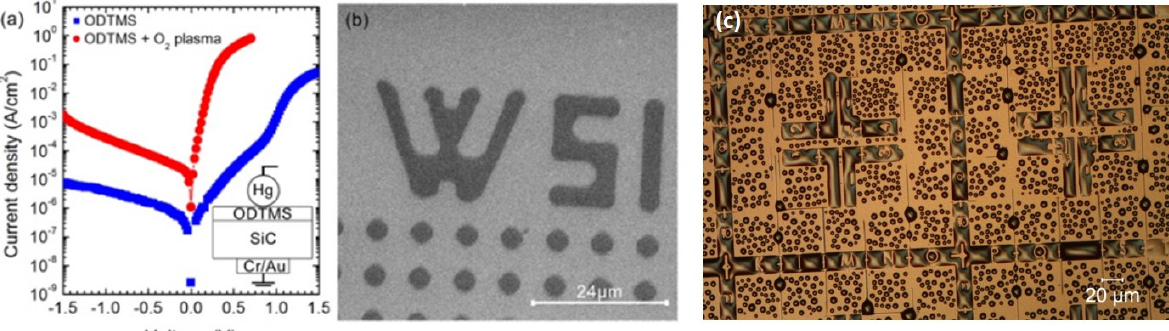
Figure 6. SAM synthesis (ODTMS-functionalized) on 6H-SiC. ( a ) IV curves and ( b ) SEM micrograph of regions with different electrical conductivities. Dark areas indicate oxygen plasma-treated regions. ( c ) Wettability image of micropatterned ODTMS-modified SiC surface. Note water droplets condense preferentially in hydrophilic oxygen plasma-exposed regions [2].